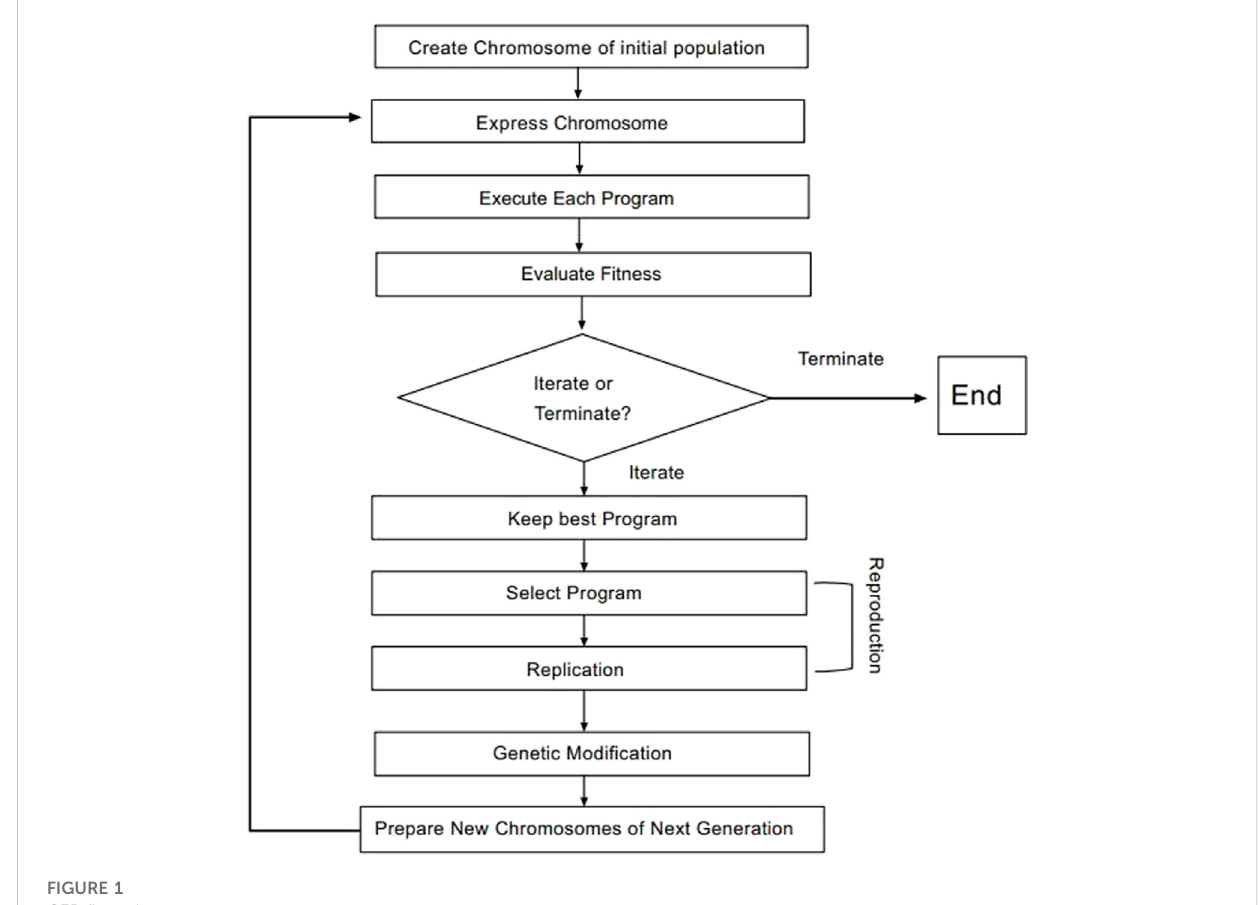
FIGURE 1 GEP fl ow chart.